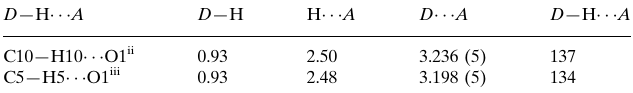
Hydrogen-bond geometry (A˚ , (cid:4)